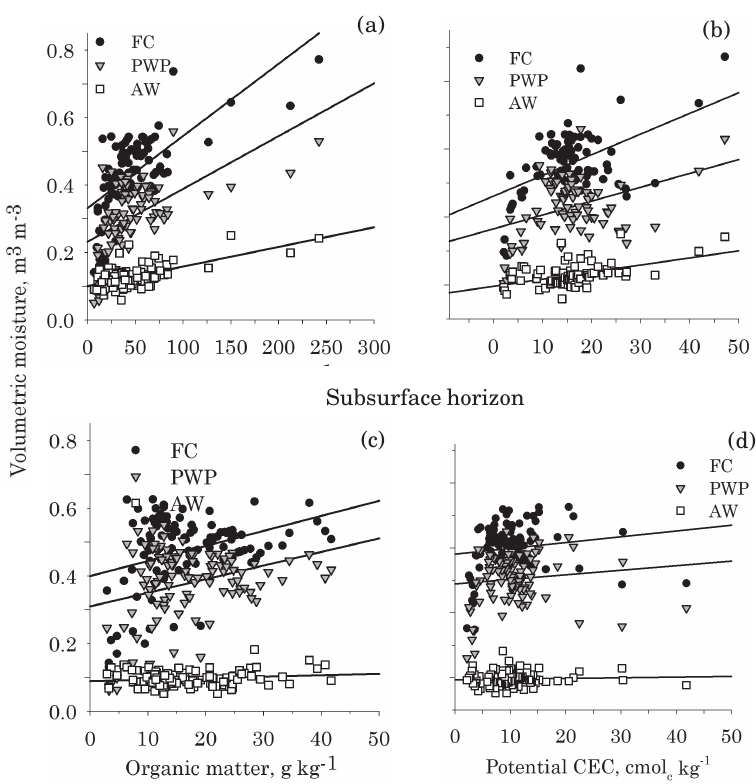
Figure 5. Scatter plots between field capacity (FC), permanent wilting point (PWP) and available water content (AW) versus organic matter content and potential cation exchange capacity (CEC) in the surface (a, b) and subsurface (c, d) horizons in soils of the State of Santa